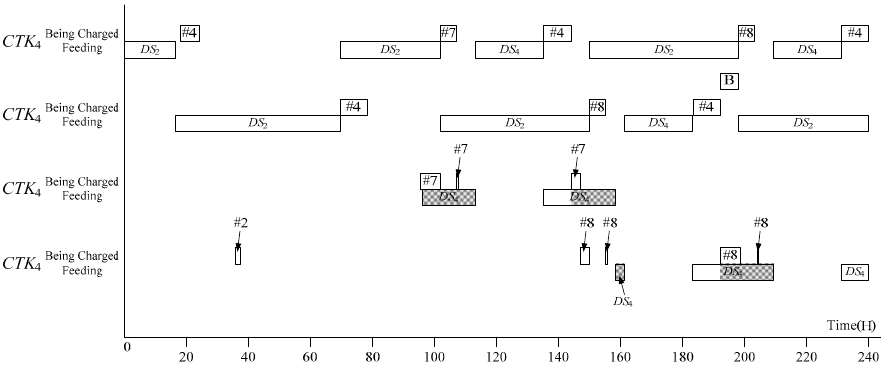
Figure 13. The schedule of charging tanks for being charged and feeding distillers.